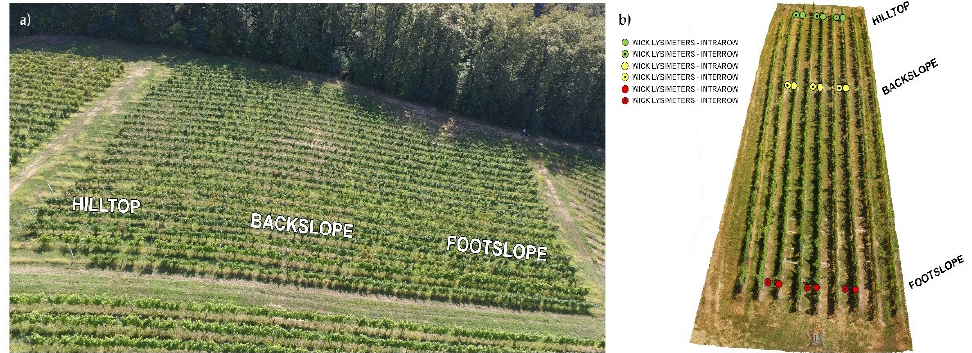
Figure 1. ( a ) Segments (i.e., hilltop, backslope, and footslope) of the SUPREHILL critical zone observatory experimental vineyard plot, and ( b ) 3D model of the SUPREHILL observatory with installation points of self-constructed lysimeters.